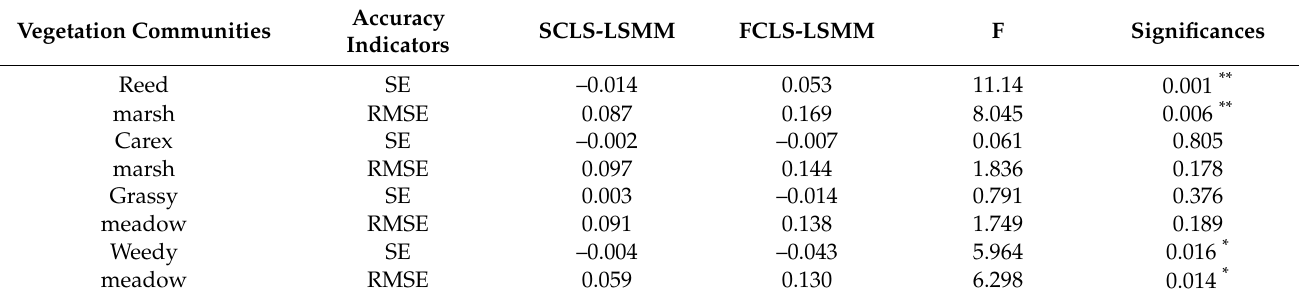
Table 2. Accuracy assessment of vegetation abundances with the proposed SCLS-LSMM and traditional FCLS-LSMM. SE is the systematic error, while RMSE is the root-mean-square error. Vegetation